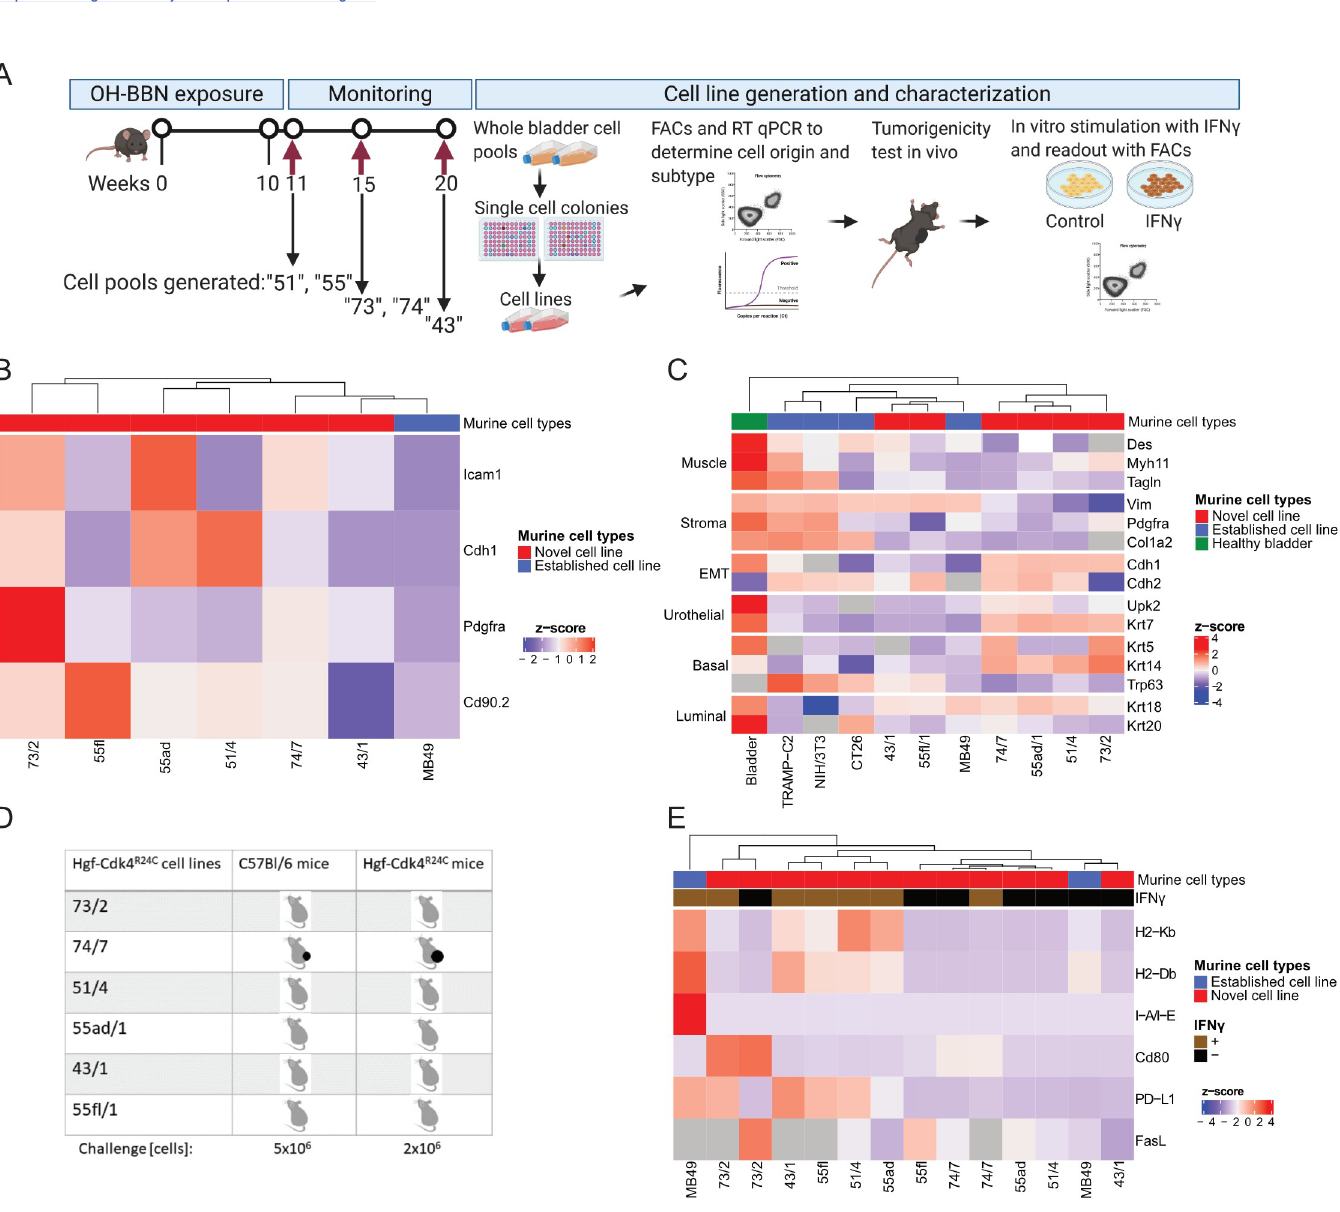
200 μ m in all tissue overview images, 50 μ m in enlarged images B-E and I-J, and 100 μ m in enlarged images F-H.) (K) Survival was significantly shorter for Hgf-Cdk4 R24C than for Cdk4 R24C mice following 10-weeks OH-BBN exposure until reaching the humane endpoint due to tumor burden (p = 0.0377). (L) Bladder volume comparison between female and male Hgf-Cdk4 R24C mice at the 10-week (p = 0.0317) and the MIBC endpoints (p = 0.1905). (M) A summary of heterogeneous histopathology findings on each murine bladder and kidney at the two endpoints (10-weeks OH-BBN female n = 5, male n = 6, MIBC females n = 6, males n = 3) in Hgf-Cdk4 R24C mice. The heatmap scale indicates the fraction animals in each group that presented each histology.